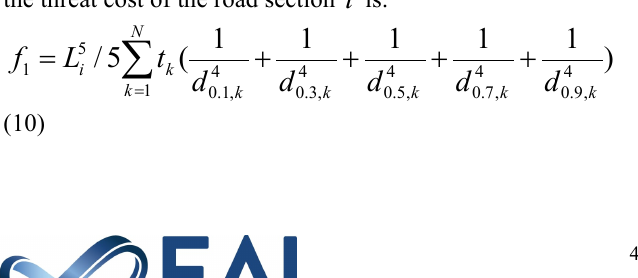
Figure 2. Schematic diagram of